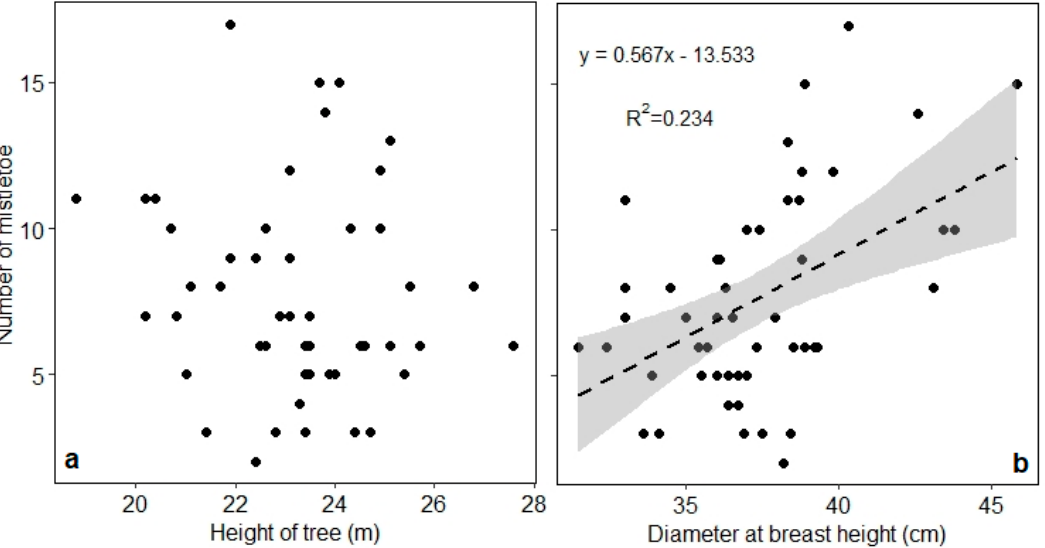
Figure 6. Relationship between the number of mistletoes and the tree height ( a ) and the tree diameter at breast height ( b ). For statistically significant relationships ( b ), the regression line (dashed line) and the 95% confidence interval (grey area) are displayed.